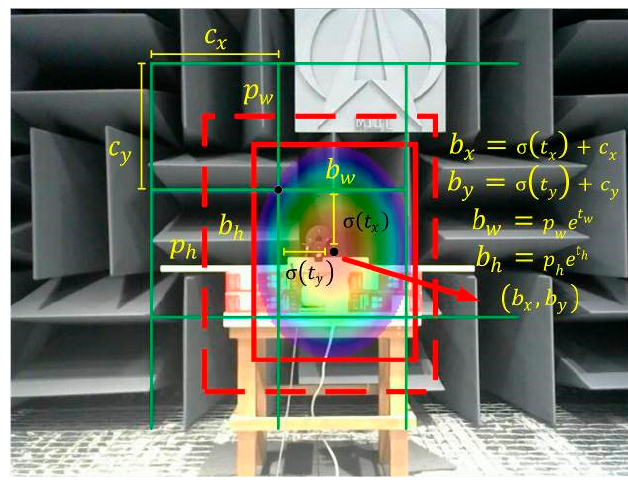
Figure 3. Target bounding box prediction process.